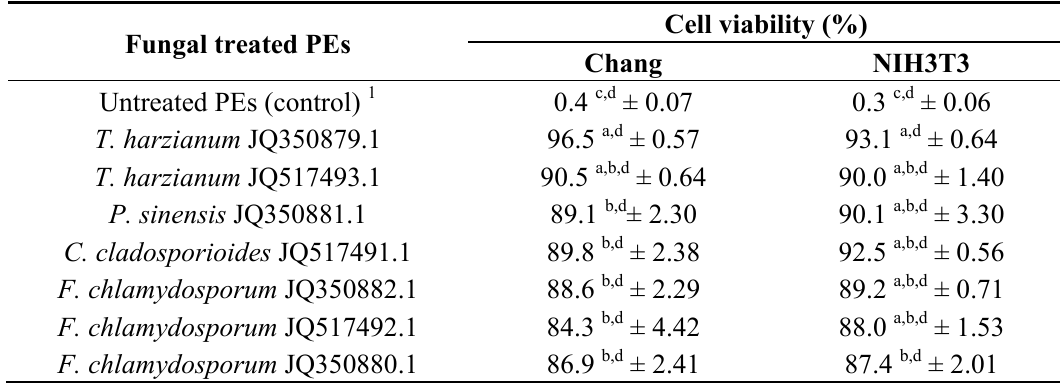
Table 2. Percentage of cell viability of Chang liver and NIH 3T3 cell lines exposed to 250 µg/mL of dimethyl sulfoxide (DMSO) extract of fungal cultures containing PEs-rich fraction after 30 days